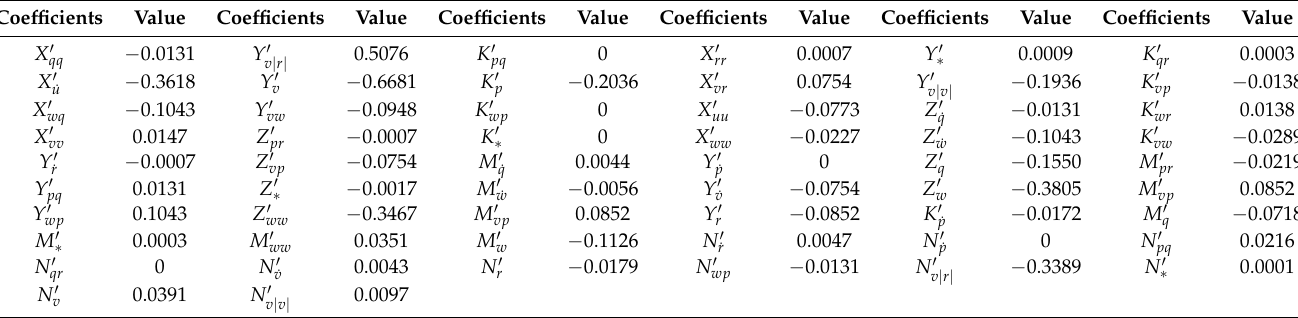
Table 3. Summary of the estimated hydrodynamic coefficients by towing experiment and PMM experiment simulation.